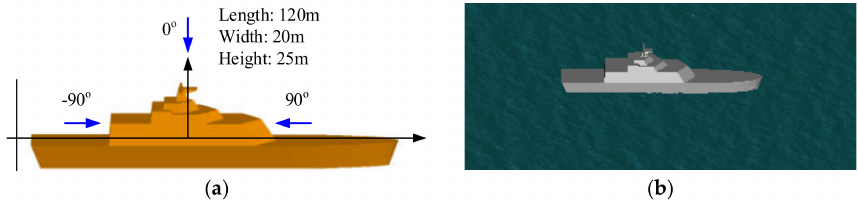
Figure 4. Geometry structure of the ship target 1 ( a ) and the composite scene ( b ).